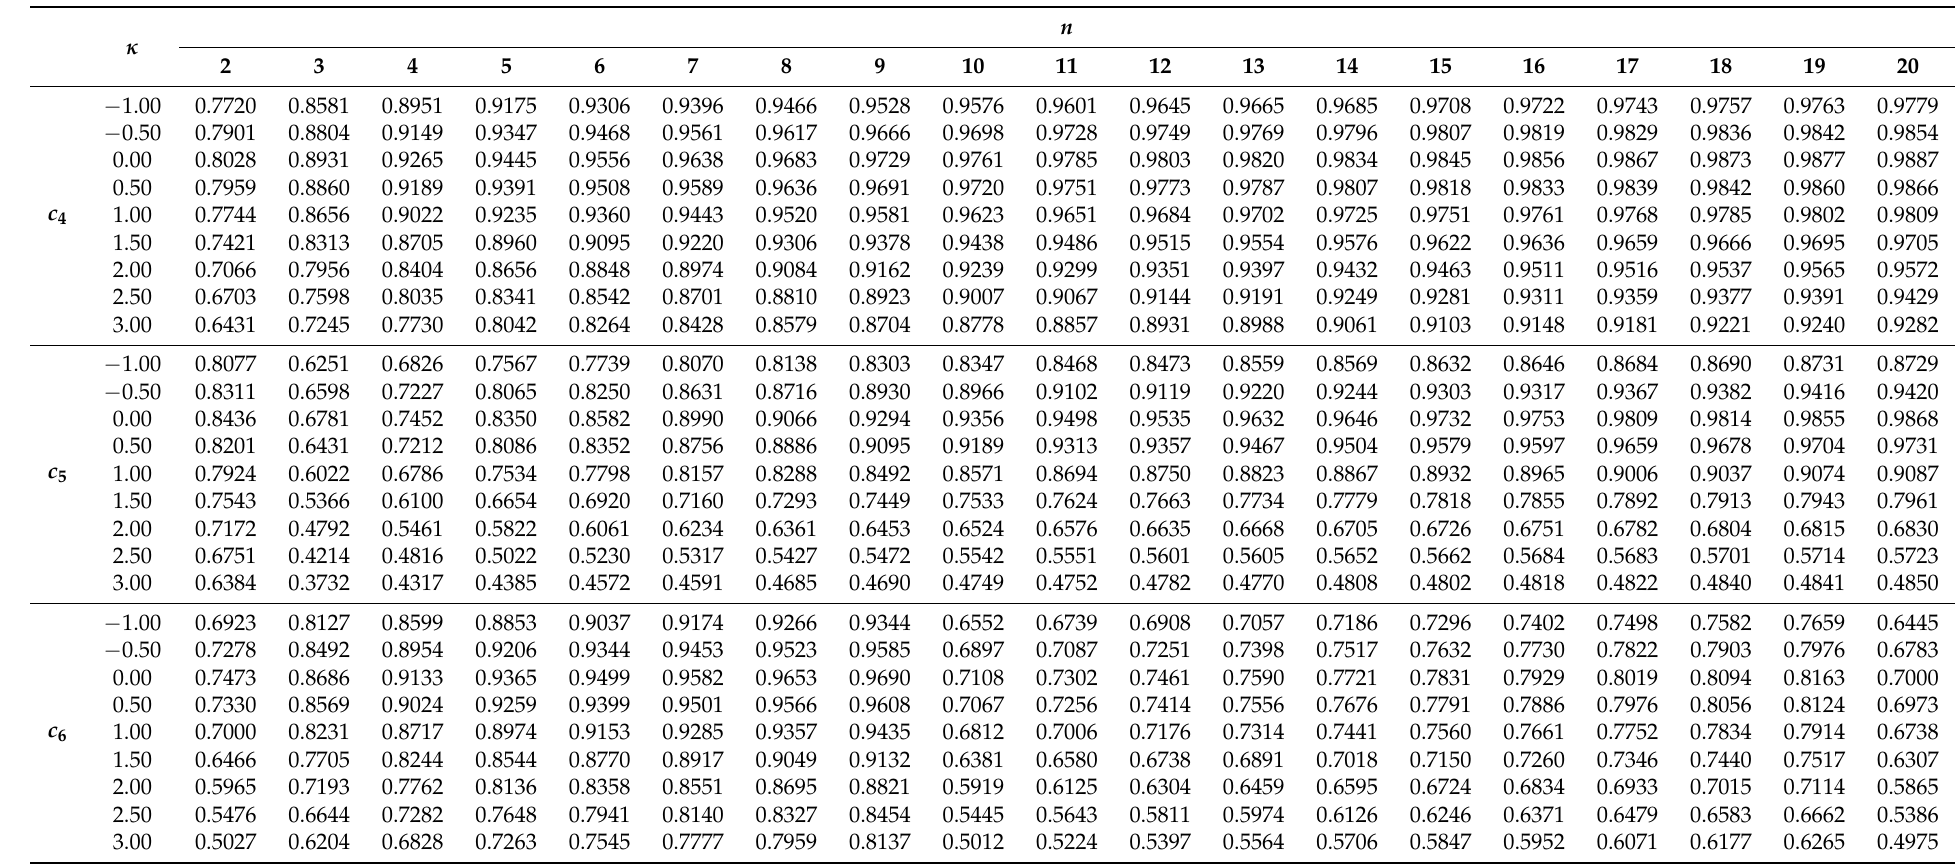
Table 2. Estimated scaling factors of three scale estimators with different n and κ of a Weibull